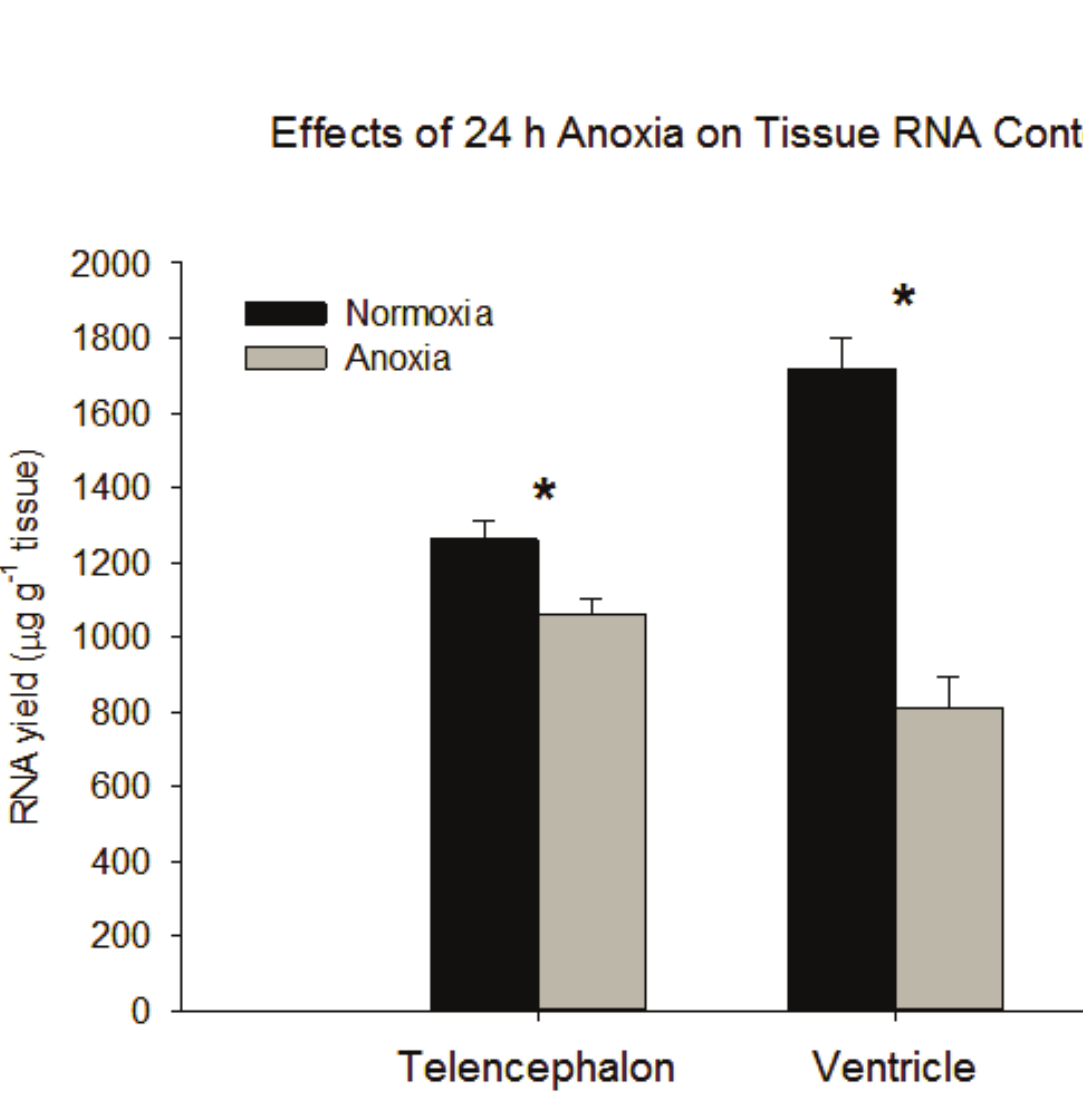
Values represent means ± SEM. N = number of individuals sampled per treatment group.